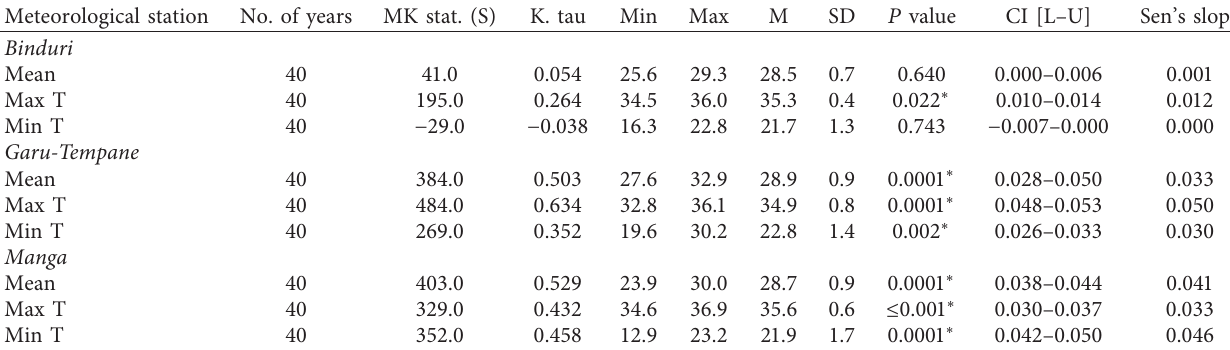
Table 6: Mann–Kendall trend test for annual